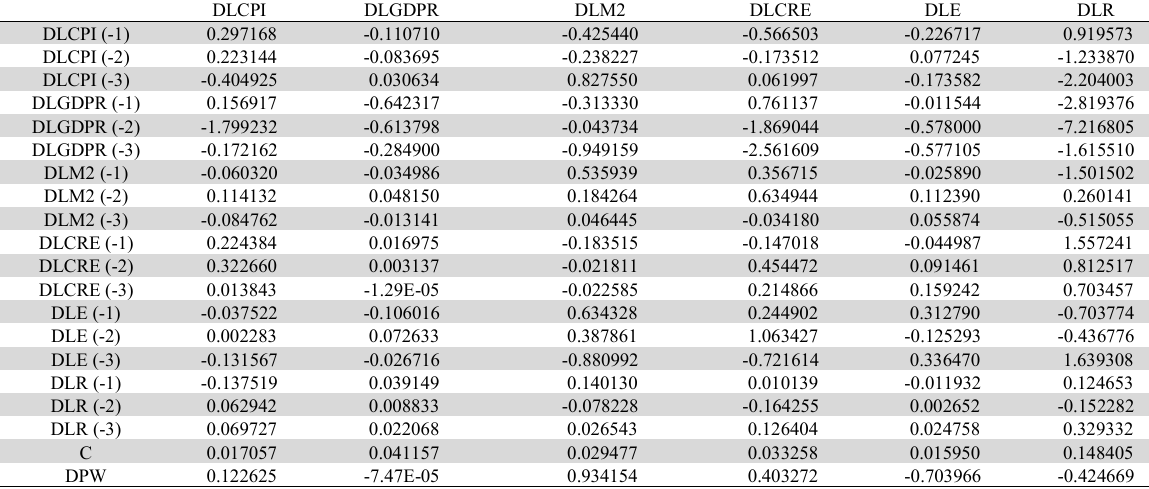
Estimation of VAR model